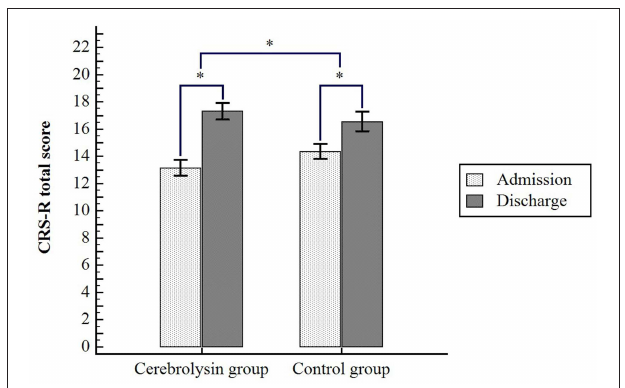
FIGURE 2 | Changes of JFK-CRS total scores in both groups from admission to discharge. * p < 0.05 comparing CRS-R total scores at discharge with scores at admission in each group by paired t -test, and comparing Cerebrolysin group vs. control group over time by linear mixed model